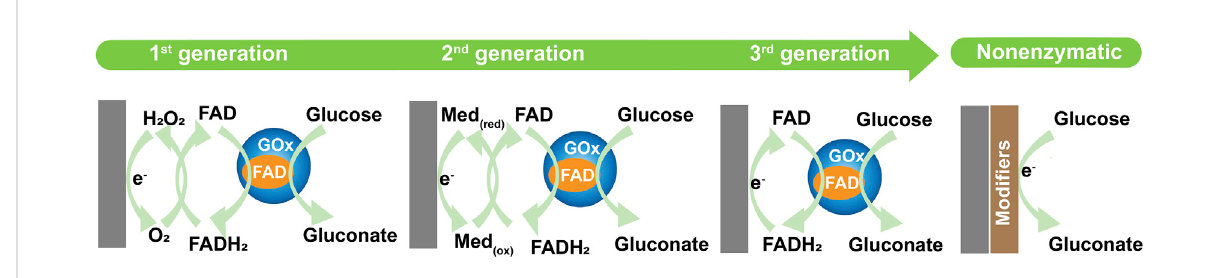
FIGURE 1 Summary of glucose oxidation mechanisms, presented as fi rst, second, third, and